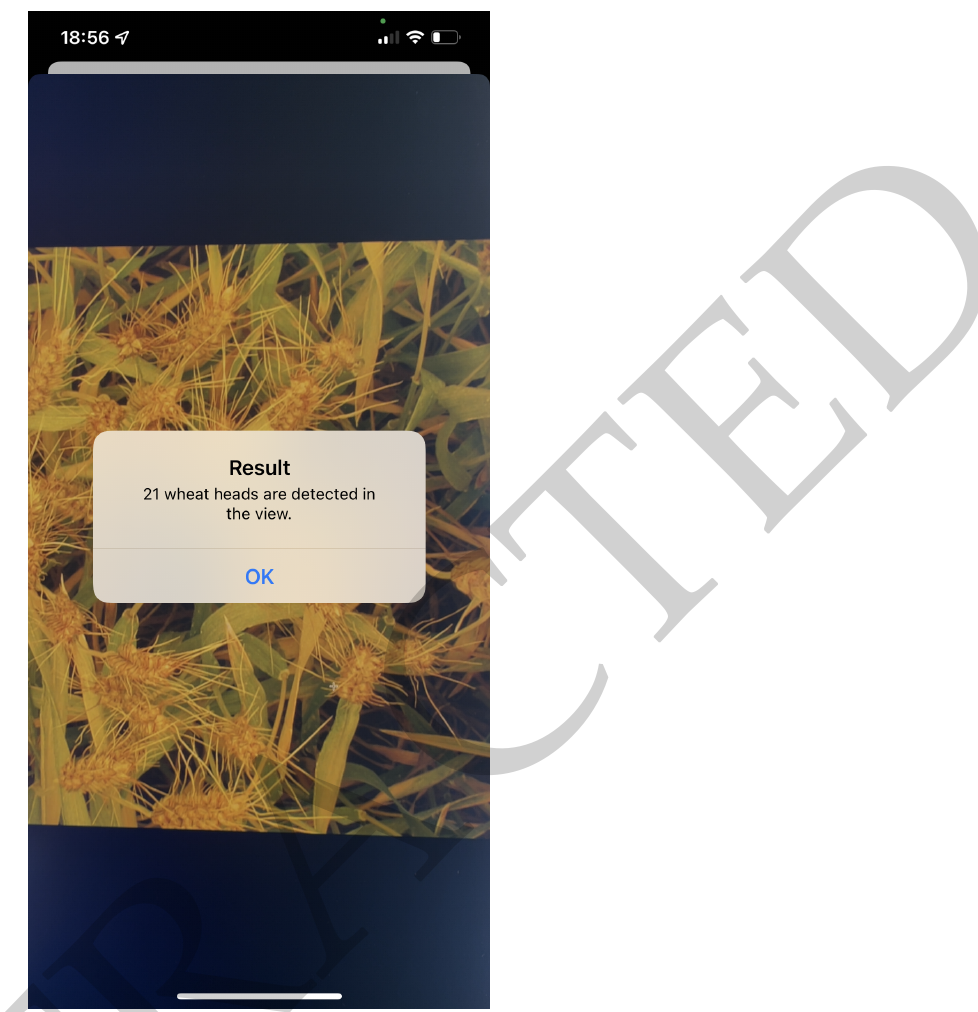
Figure 10. Screenshot of the intelligent wheat detection system on an iOS